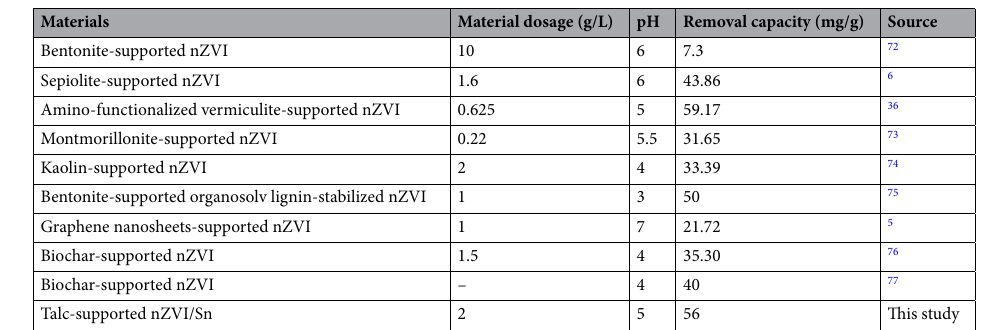
Table 4. Comparison of maximum removal capacity of Cr(VI) by supported-nZVI